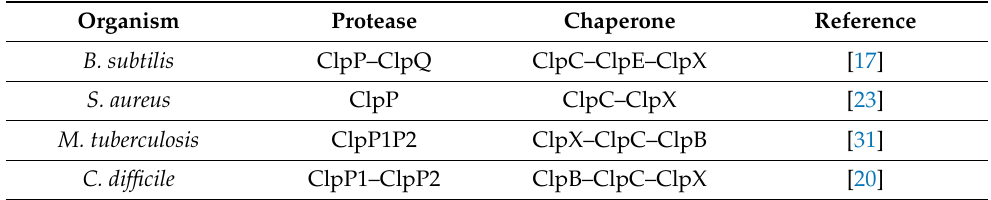
Table 1. Different proteases and chaperones in Gram-positive bacteria.